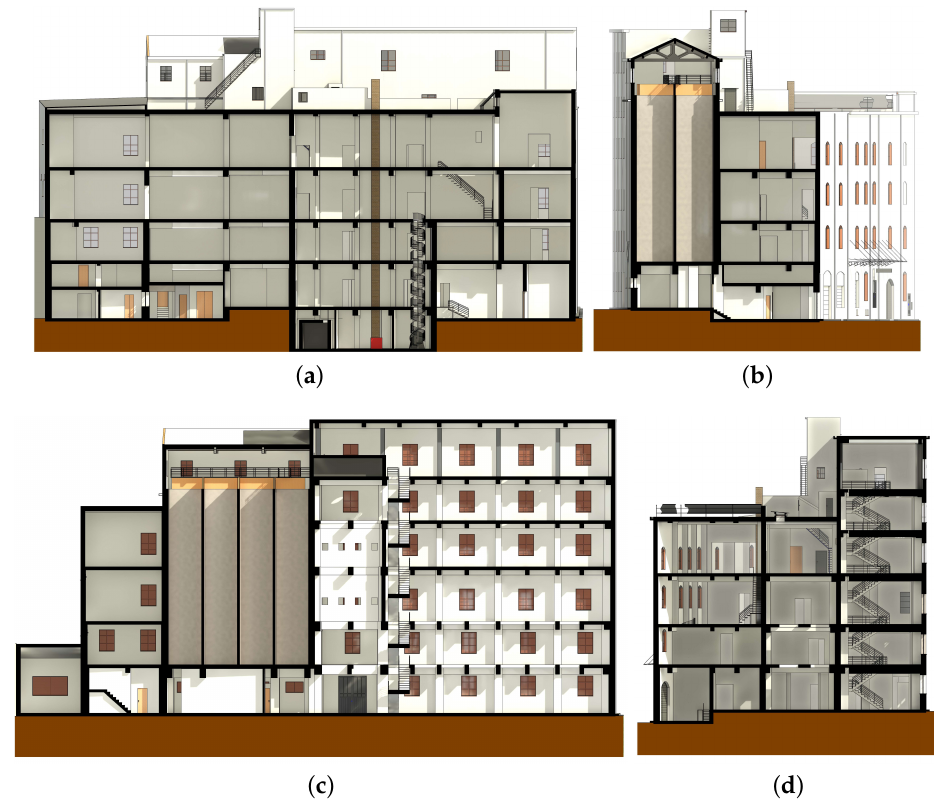
Figure 12. Digital drawings: Building internal